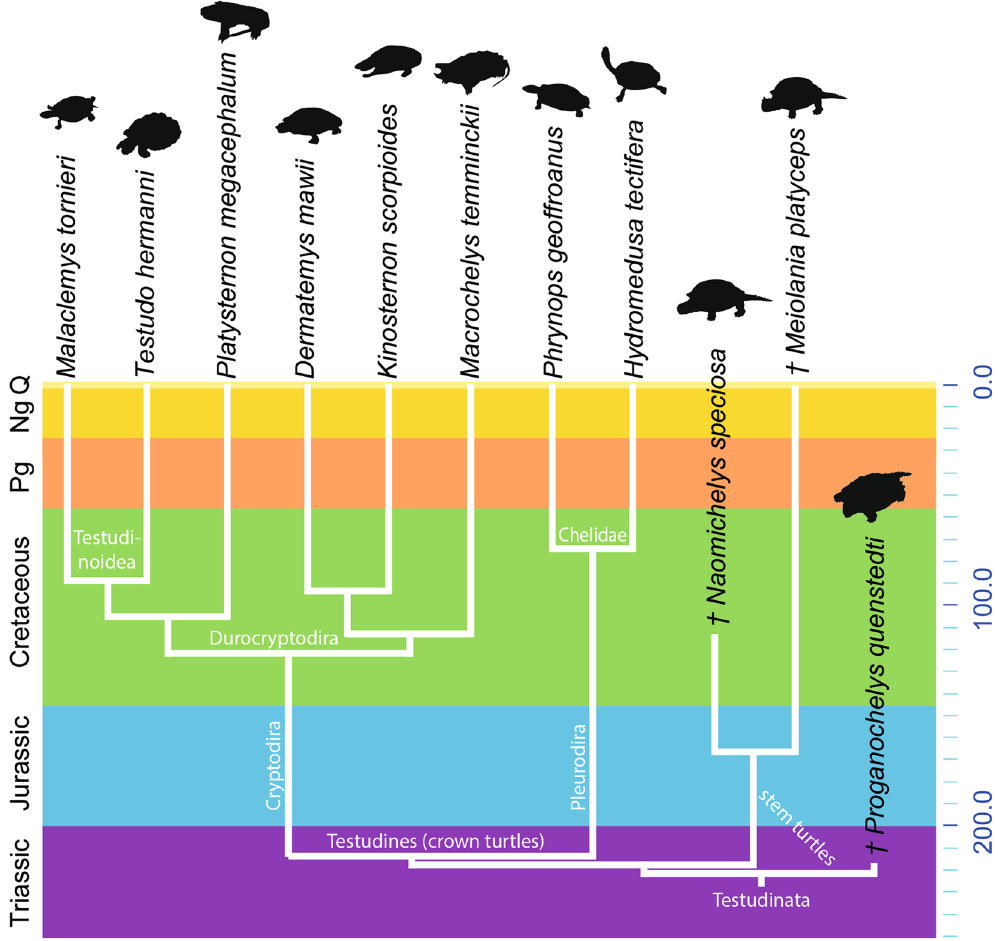
Figure 1. Taxon overview. Phylogenetic arrangement, divergence times, and stratigraphical distribution of the species analyzed in the present study. Divergence times follow Joyce et al .